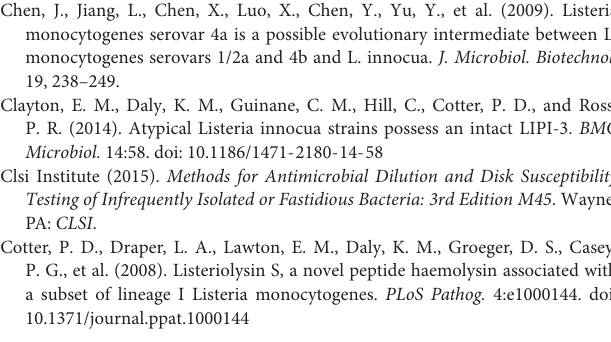
Supplementary Figure 1 | LIPI-4 phylogenetic tree of 4 L. innocua isolates with reference L. innocua and L. monocytogenes . Phylogenetic tree was built with FastTree and modified by FigTree using LIPI-4 sequences of 4 L. innocua and from NCBI nt/nr database. Root was set as midpoint. Supplementary Figure 2 | Genome phylogenetic tree of 4 L. innocua isolates with reference L. innocua and L. monocytogenes . Phylogenetic tree was built with FastTree (v2.1.10) and modified by FigTree using whole genome sequences of 4 L. innocua and completely assembled reference genomes of L. monocytogenes and L. innocua from NCBI assembly database. Root was set as midpoint. L. innocua strains were marked in blue. L. monocytogenes strains with LIPI-4 were marked in red, while the strains without LIPI-4 were marked in